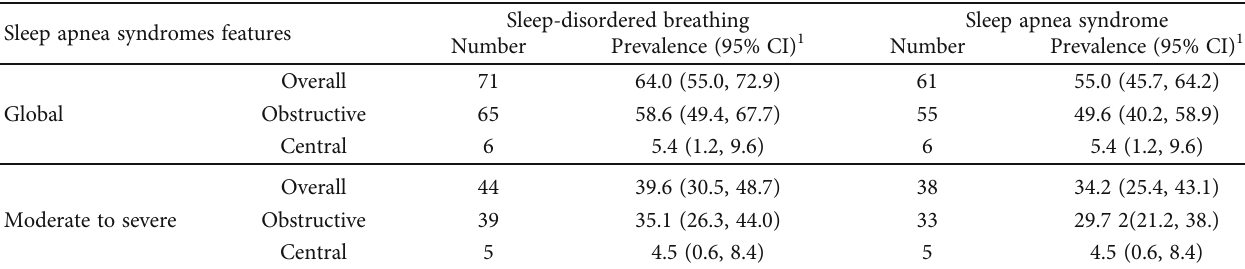
Table 2: Prevalence of sleep-disordered breathing and sleep apnea syndrome according to type and severity, among hospitalized patients in Yaoundé Central Hospital, November 2016 – May 2017, Yaoundé, Cameroon. N = 111